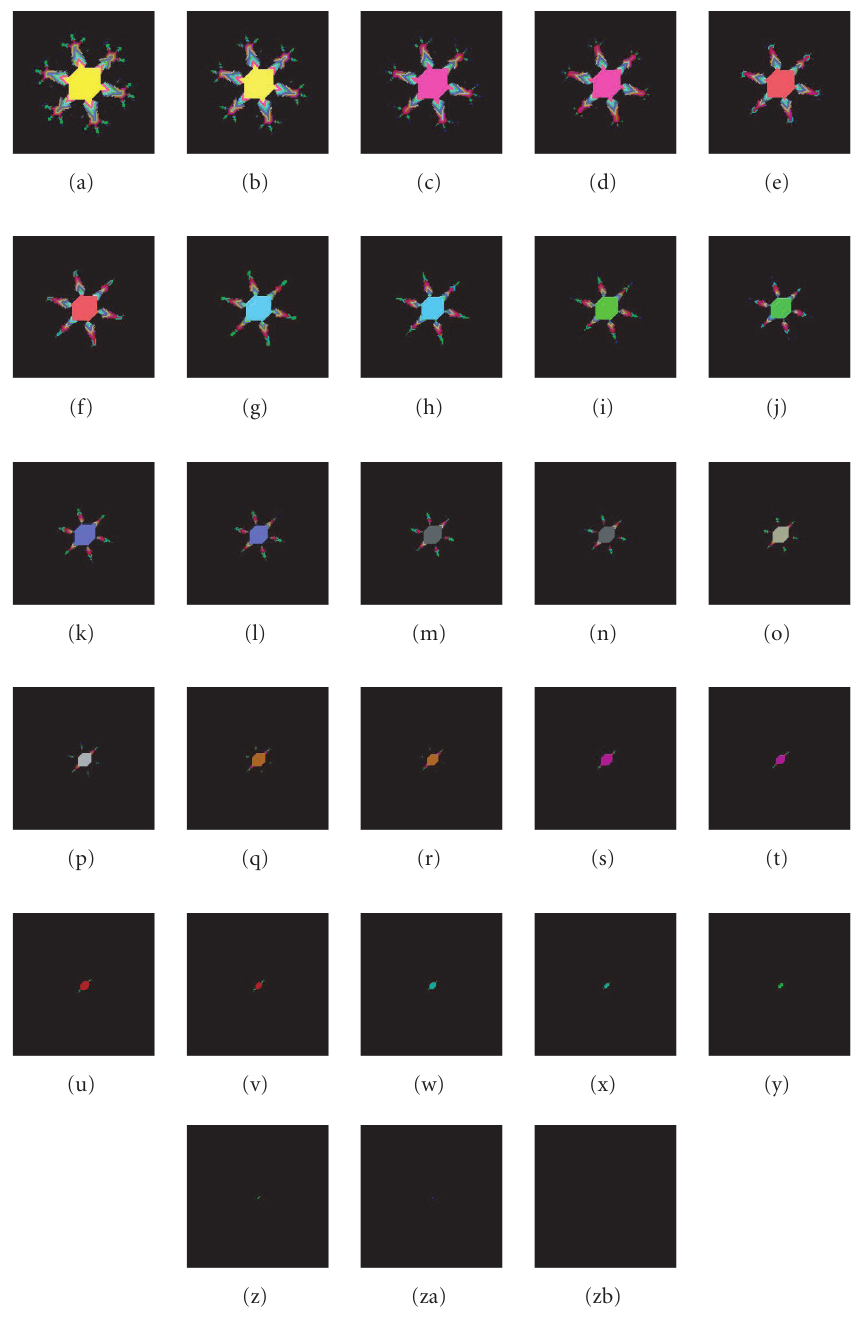
Figure 3.3. Pore-throat network from eroded versions of fractal